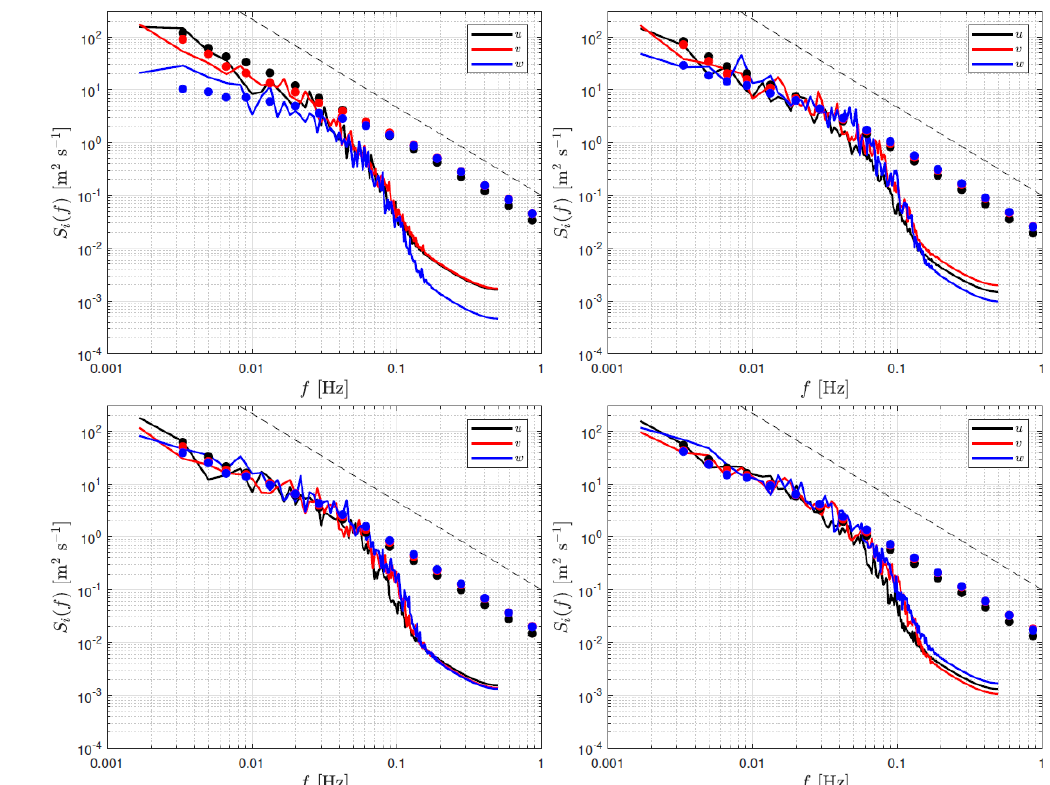
Figure 14. Similar to Fig. 13 but for unstable